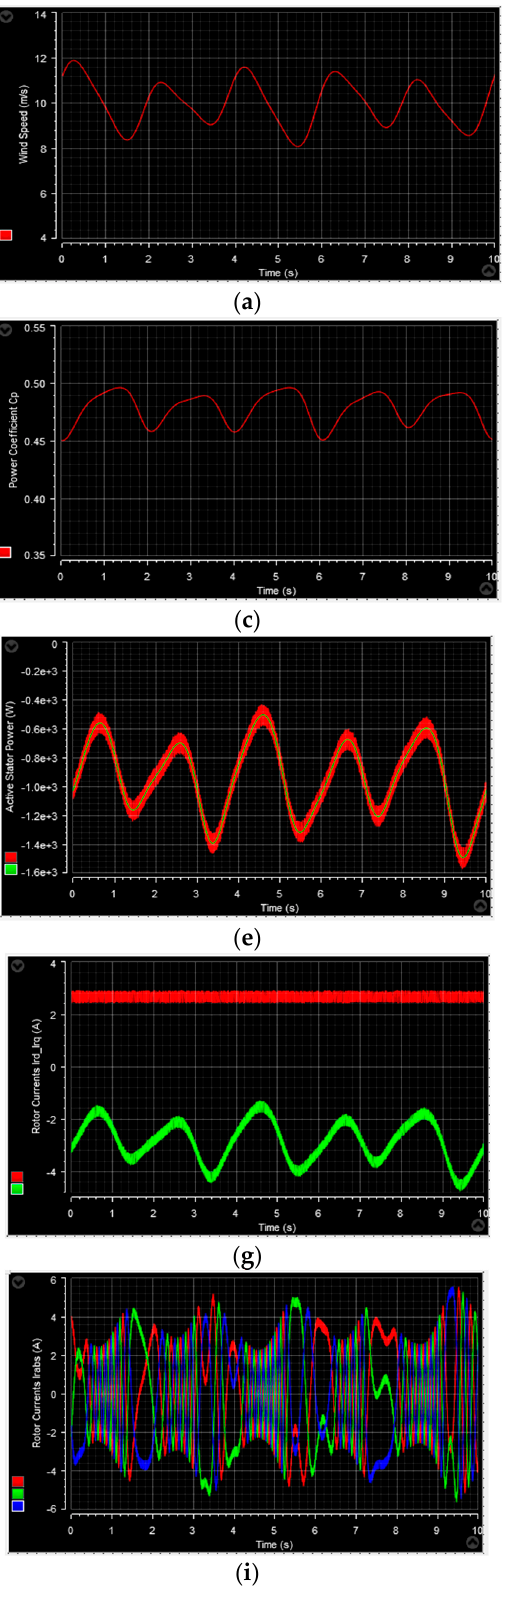
Figure 25. Experimental results. ( a ) Wind speed profile, ( b ) generator speed, ( c ) Cp , ( d ) tip speed ratio, ( e ) Ps , ( f ) Qs , ( g ) quadrature and direct rotor current, ( h ) power factor, ( i ) rotor current, ( j ) stator current.